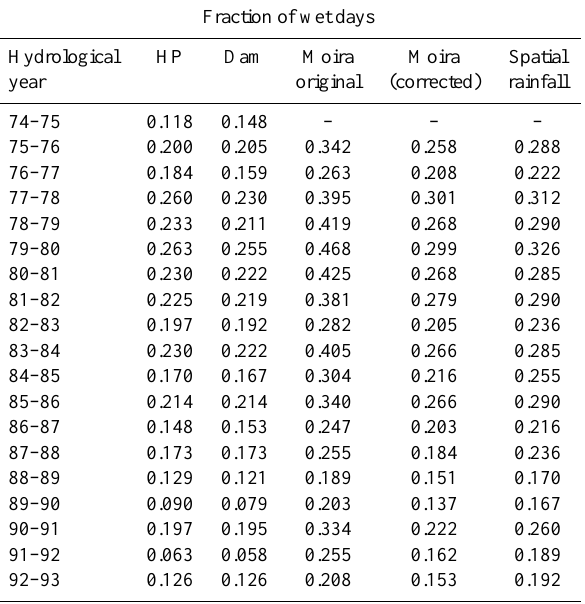
Table 5. Fraction of wet days for the observed, corrected and calcu- lated rainfall